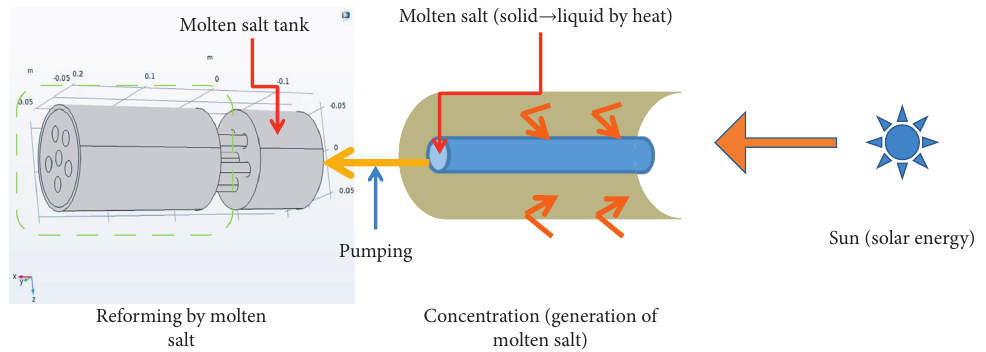
Figure 1: Conversion of solar energy to hydrogen. The green-dashed box is the focus of this study.